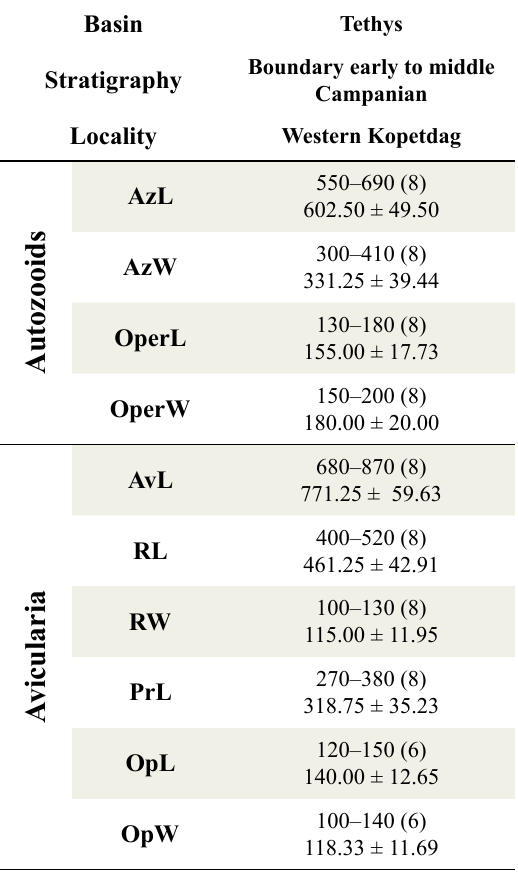
Table 6. Summary of measurements of Rhagasostoma operculatum sp. nov. For each parameter the range is given with the number of measurements in brackets. The arithmetic mean is given ± standard deviation. All measurements in